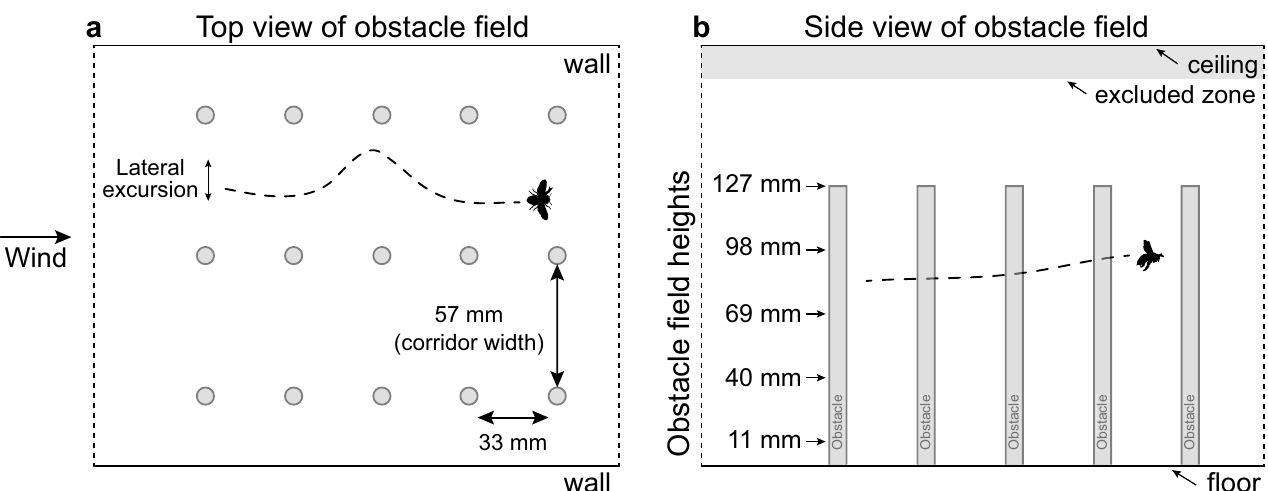
Fig 1. Schematic of experimental obstacle field. (a) Top view: obstacles in each field were arranged in three rows of five vertical columns each, forming two 57-mm wide, unobstructed flight corridors down the longitudinal axis of the enclosure. Bees’ flight paths within the horizontal plane (from above) were used to calculate lateral excursions (interquartile range of lateral positions throughout the flight). (b) Side view: the total height of the tunnel was 191 mm, and five obstacle field heights, ranging from 11 to 127 mm, were tested. Flights that crossed into the ‘excluded zone’ (within 15 mm of the ceiling; gray area on figure) were